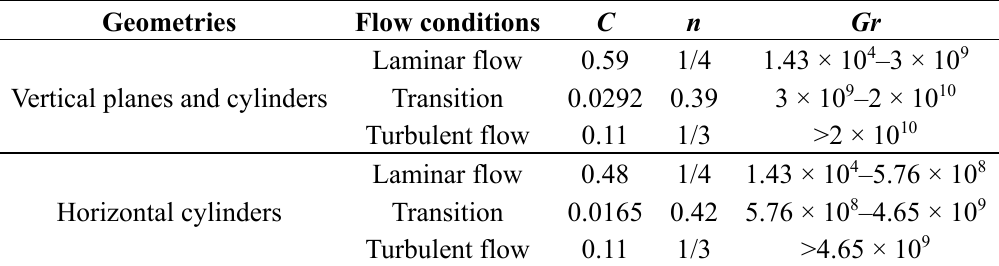
Table 3. Constants in Equation (9).